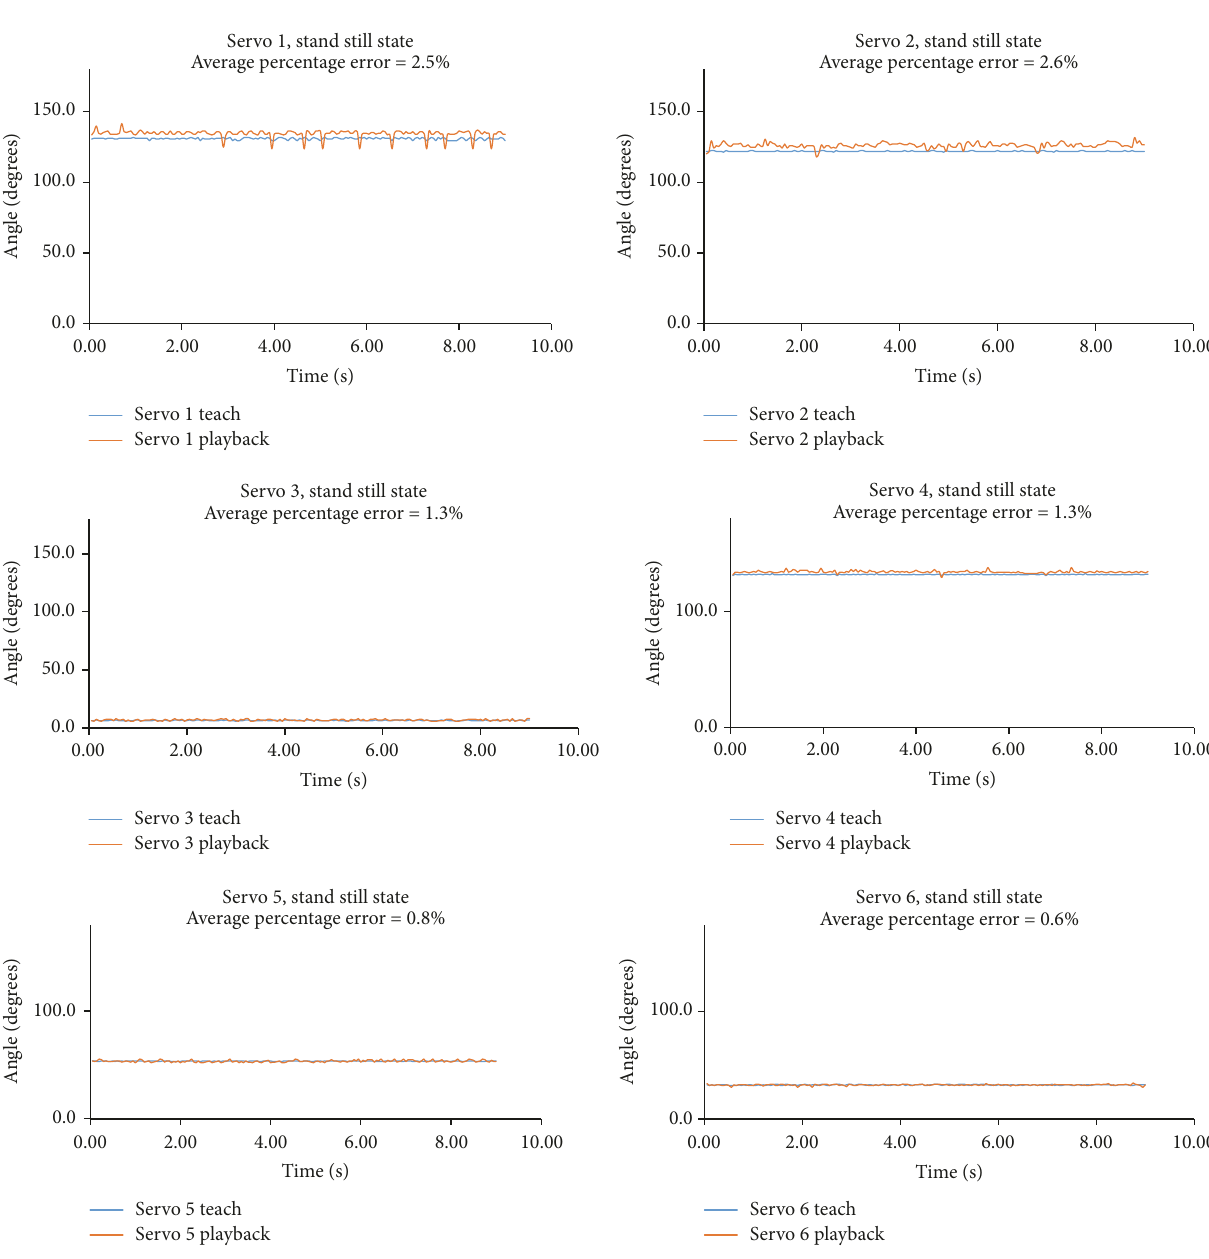
Figure 4: Fixed-position servo values during the “teach” and “playback”